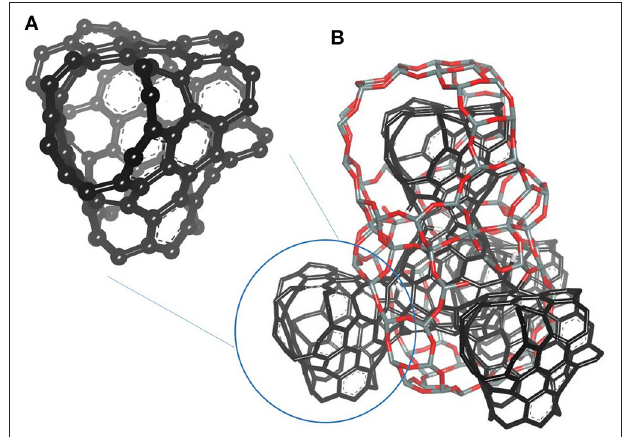
FIGURE 6 | The proposed model of (A) single C 72 unit and (B) the framework of C 72 units connected in a tetrahedral configuration that is embedded inside the FAU framework. Note that the gray and red sticks represent the FAU template, whereas the black sticks are for the